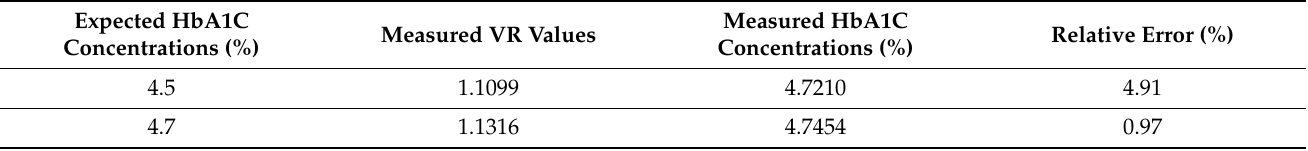
Table 1. Measured HbA1C concentrations (%) from the calibration